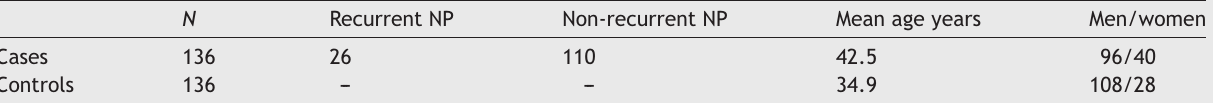
Baseline characteristics of study subjects in a study that investigated the relationship between MMP-2 gene polymor- phisms and the risk of nasal polyps